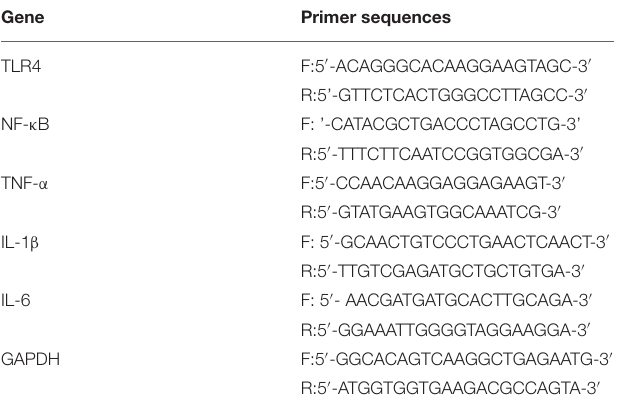
TABLE 1 | PCR primers used in the study. Gene Primer